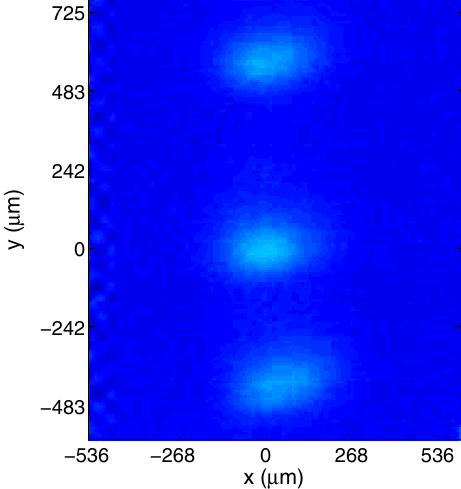
FIG. 9. Beam image at synchrotron diagnostic beam line 3.1 measured with a nongated CCD camera. For this measurement, the storage ring was filled with a 5 mA single camshaft bunch, and the beam was kicked at the maximum kick-and-cancel frequency.